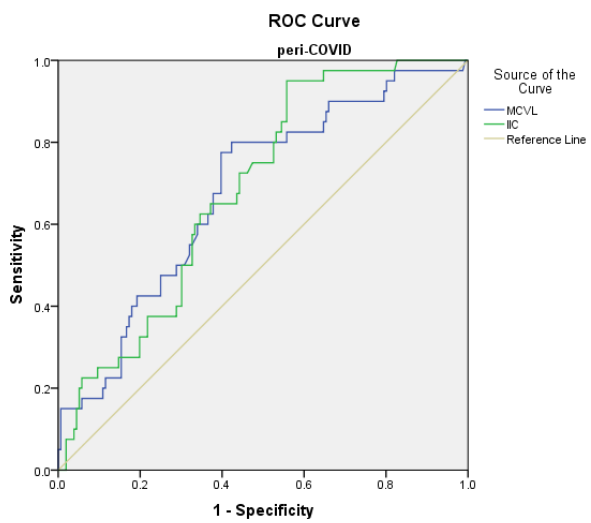
Figure 3. Receiver operating characteristic (ROC) curve for logistic regression models of inflammatory markers related to complications in the peri-COVID